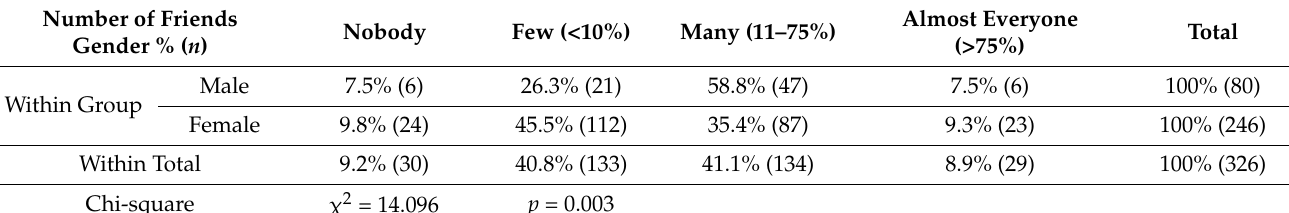
Table 4. Number of friends/colleagues who